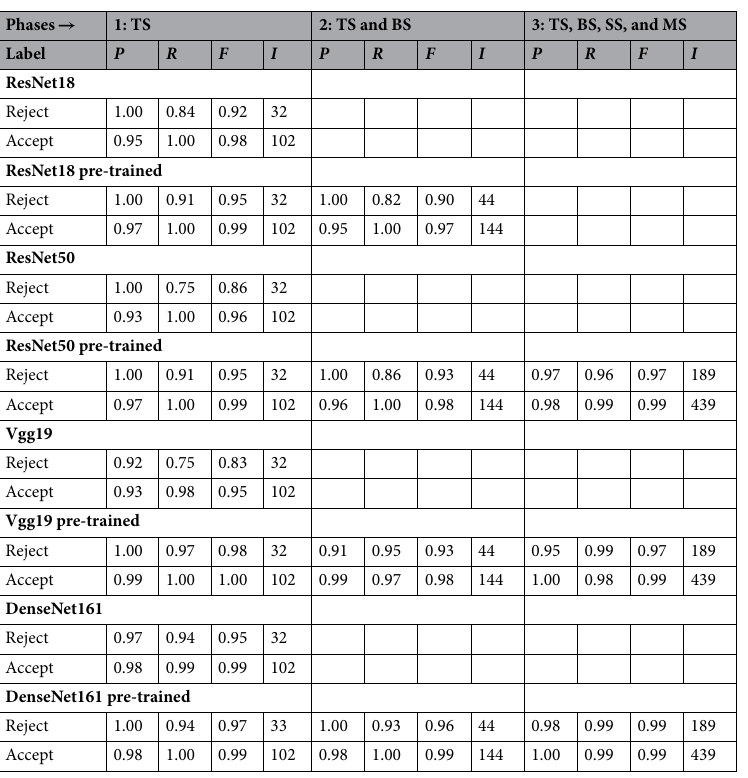
Table 5. Precision ( P ), recall ( R ), F-score ( F ) and number of validation images (I) for each of the CNN models and for each phase of the training process (TS, BS, SS and MS correspond to top, bottom, side and middle sealing,